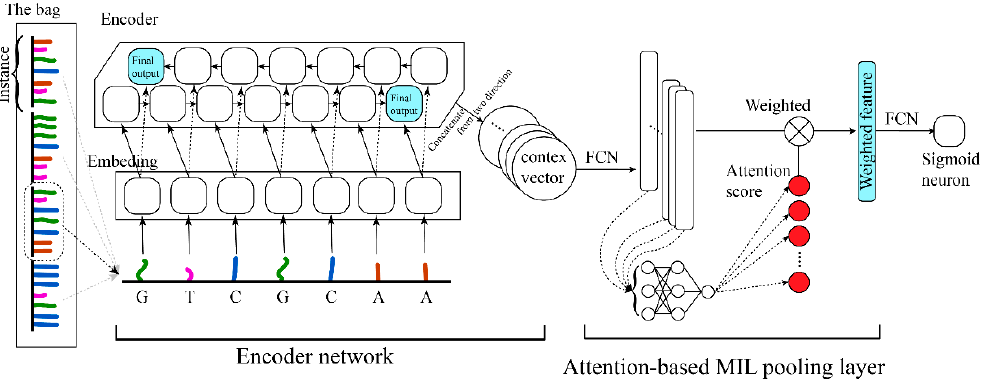
Figure 2. Illustrations of attention ‐ based deep encoder MIL model structure (Circ ‐ ATTEN ‐ MIL).